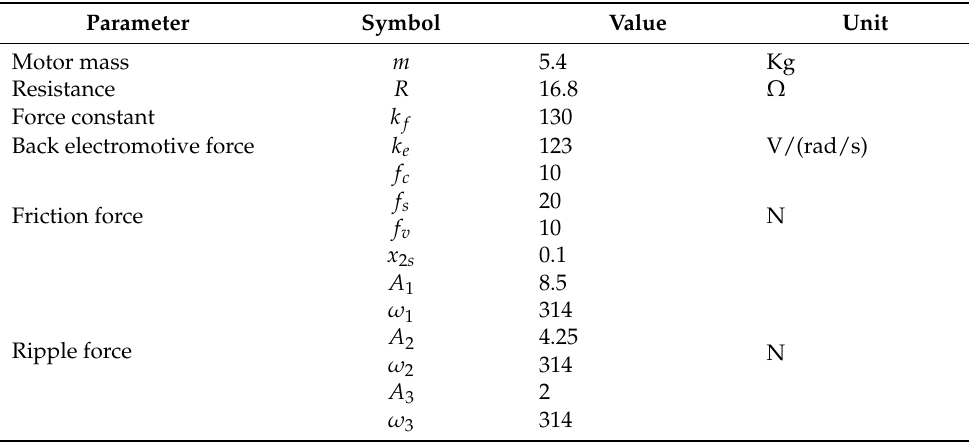
Table 1. Parameters of the PMLM